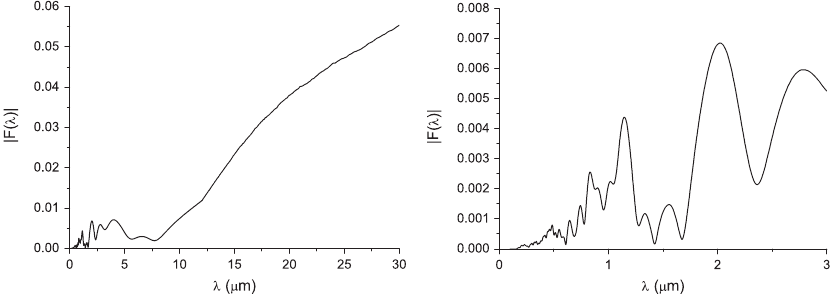
FIG. 9. Modulus of the bunch form factor (corresponding to realization in the time domain shown in Fig. 8) versus wavelength, and an enlarged fraction of this